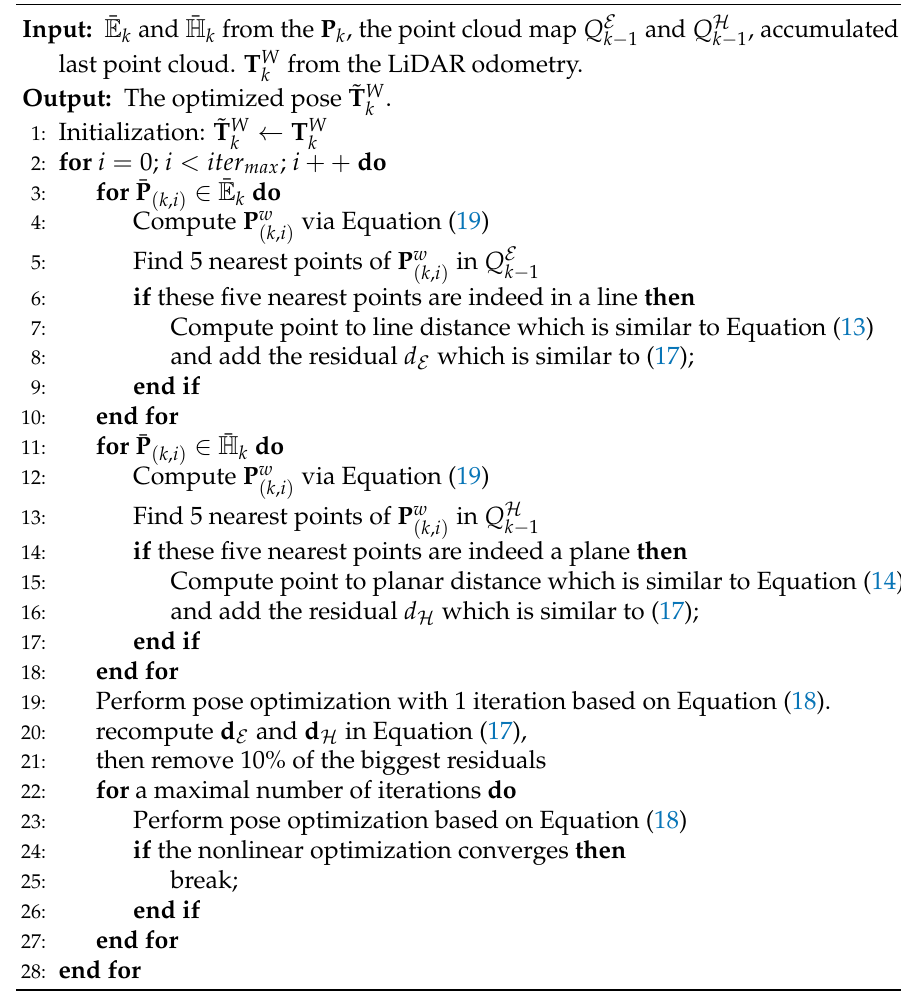
Algorithm 1 LiDAR